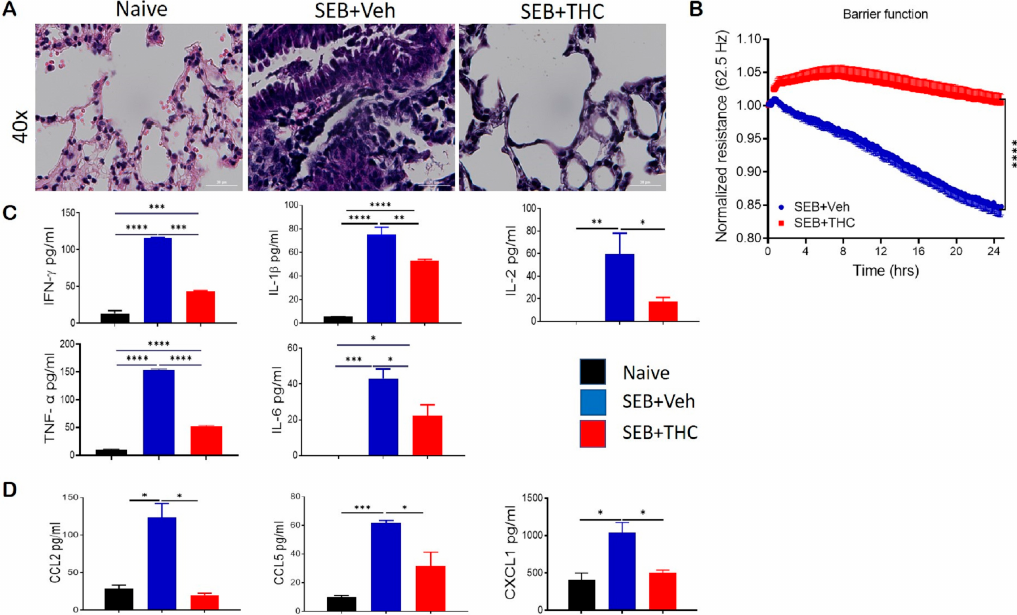
Figure 1. ∆ 9-Tetrahydrocannabinol(THC) attenuates staphylococcal enterotoxin-B, SEB-induced acute respiratory distress syndrome (ARDS) in mice. For in vivo studies, SEB-mediated ARDS was induced in C3H / HeJ mice, then the mice were treated with either vehicle (Veh) or THC, as described in Methods. For in vitro studies, epithelial cell type II was cultured, and the resistance was measured after adding splenocytes, which were activated with SEB + Veh or SEB + THC. ( A ): Representative hematoxylin and eosin, H&E images of lung tissue sections. ( B ): ECIS measurement of epithelial resistance, presented resistance is normalized to a pre-treatment time point for comparison of THC e ff ect on barrier function. ( C , D ): ELISA quantification of broncho-alveolar lavage fluid (BALF) for cytokines (C) and chemokines (D). Vertical bars show data from 5 mice with mean +/ -SEM. Statistical significance is depicted as * p < 0.05, ** p < 0.01, *** p < 0.001, and **** p < 0.0001 between the groups.